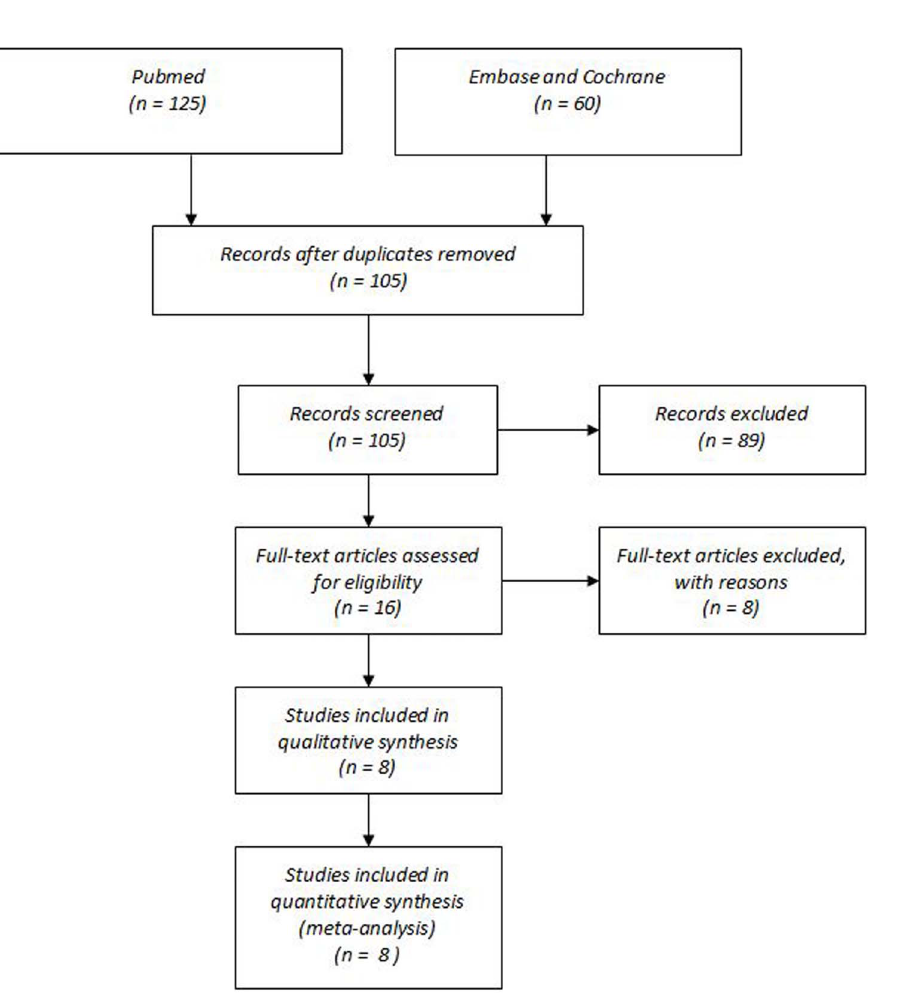
Figure 1. Flowchart of selection of studies for inclusion in meta-analysis. doi:10.1371/journal.pone.0091978.g001 PLOS ONE |